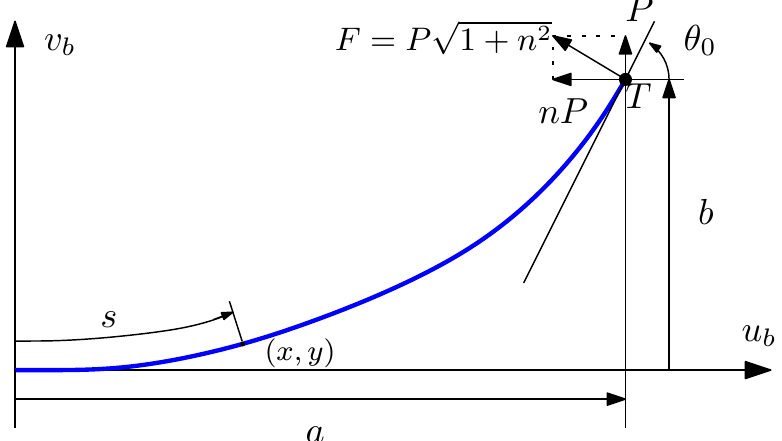
Figure 2. Geometry of beam deflection. Active length L is the arc length between fixed end and point T